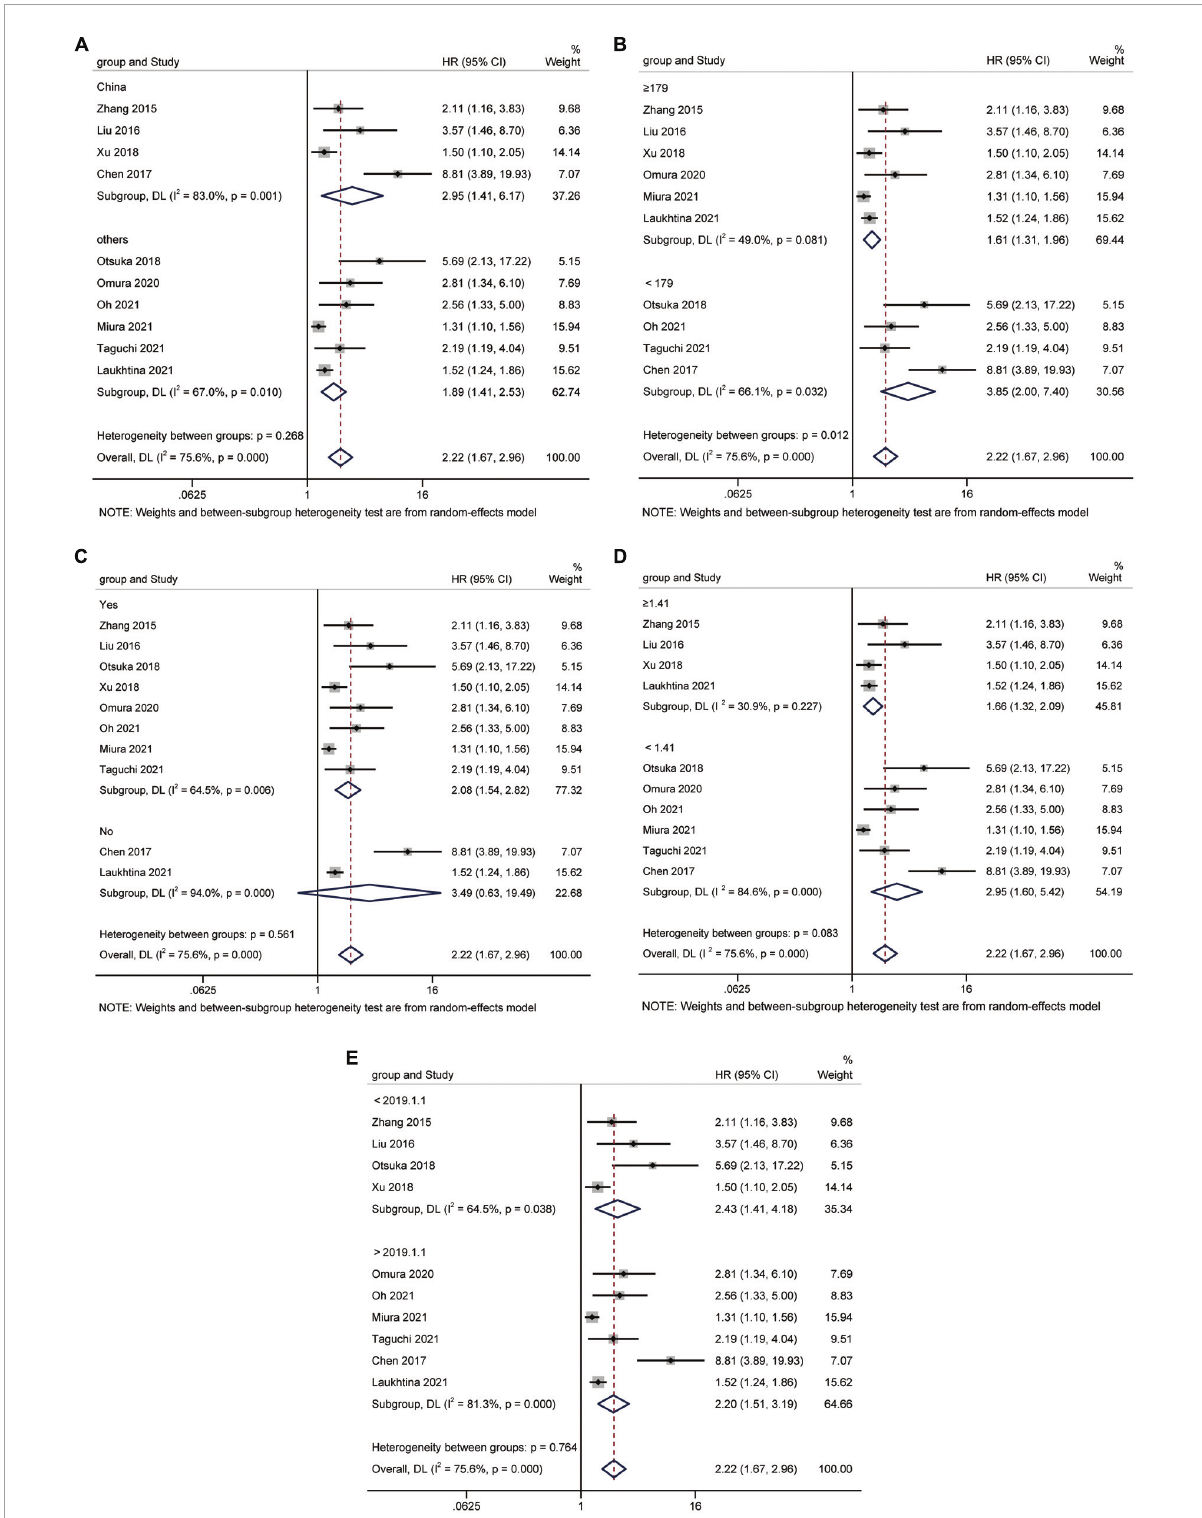
FIGURE5 Forest plot for subgroup analysis of CSS and AGR. (A) Subgroup analysis of CSS and AGR according to ethnicity; (B) Subgroup analysis of CSS and AGR according to sample size; (C) Subgroup analysis of CSS and AGR according to urothelial carcinoma (yes or no); (D) Subgroup analysis of CSS and AGR according to cut-off values; (E) Subgroup analysis of CSS and AGR according to publication